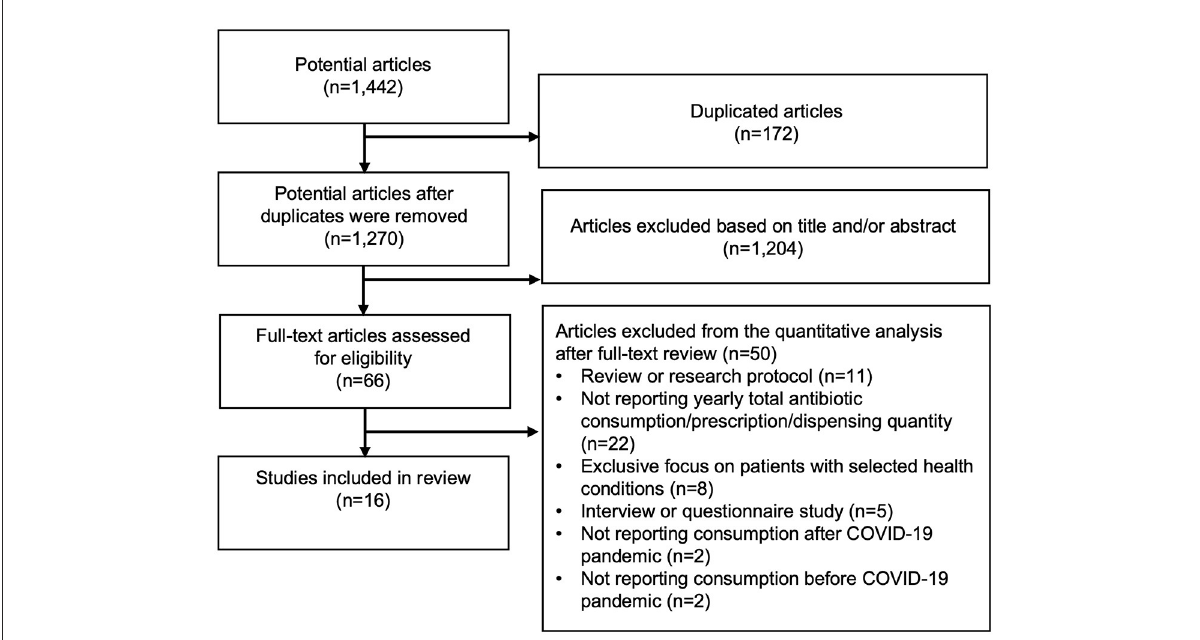
FIGURE1 A systematic review flow diagram. Diagram of the number of articles and reports identified and examined at each stage of the review. A total of 16 articles published from 2021 to 2022 met all inclusion criteria and were included in the review.